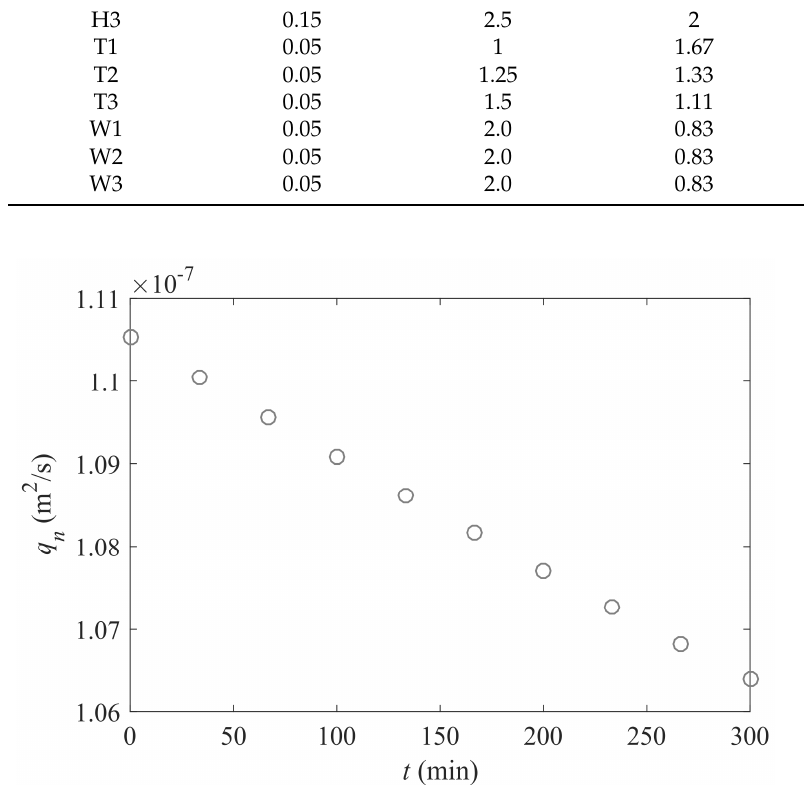
Figure 12. Temporal evolution of case H1. Table 3. Wave conditions for idealized tests.